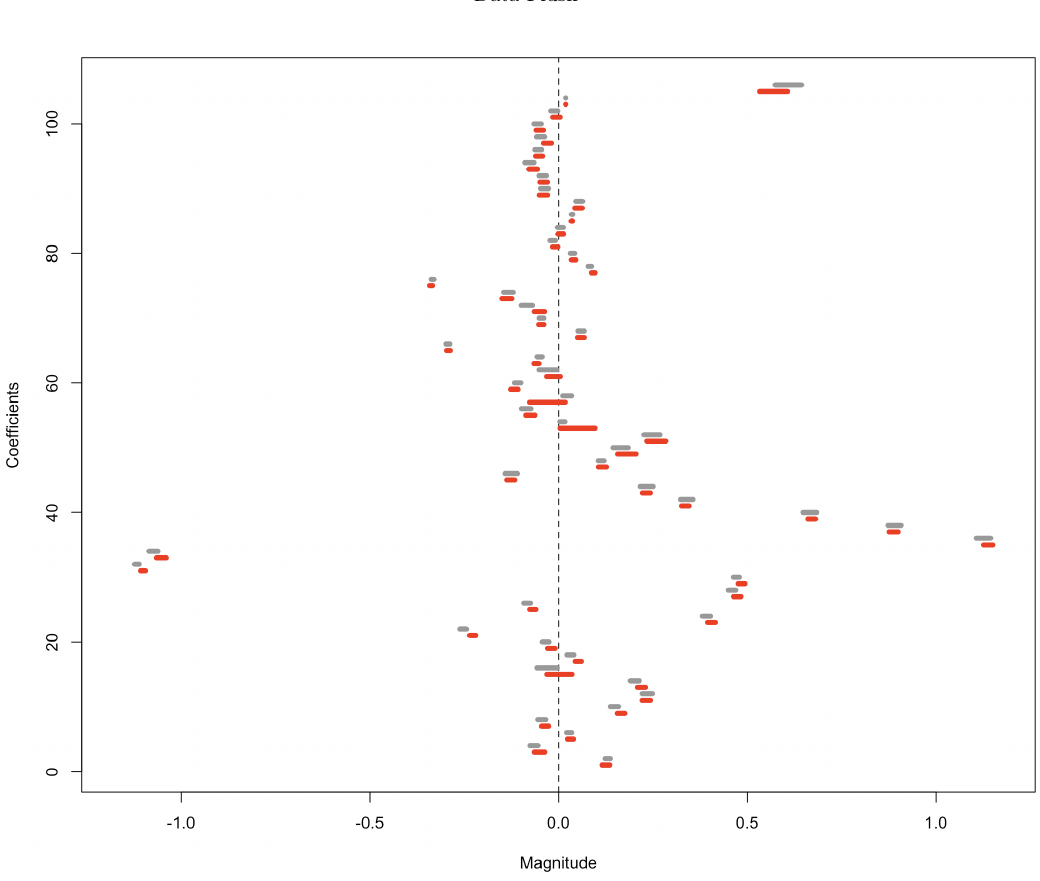
Figure 3. Confidence intervals of regression coefficients based on raw data and privatized data, represented by gray and red lines and constructed using the data-flush scheme in sec- tion 3. Regressors from the top to the bottom are the intercept (shifted to the left by 8 units for better visualization), AGE, REGION (8 dummy variables), METPOP10, METRO (2 dummy variables), MORTGAGE (2 dummy variables), SEX, MARST (5 dummy vari- ables), RACE (5 dummy variables), HISPAN, SPEAKENG (2 dummy variables), HCOV- ANY, EDUCD (6 dummy variables), EMPSTAT (2 dummy variables), OCC (12 dummy variables), MIGRATE (2 dummy variables), and VETSTAT. The confidence intervals based on raw data are comparable with those after privatization in terms of the signs of interval centers and